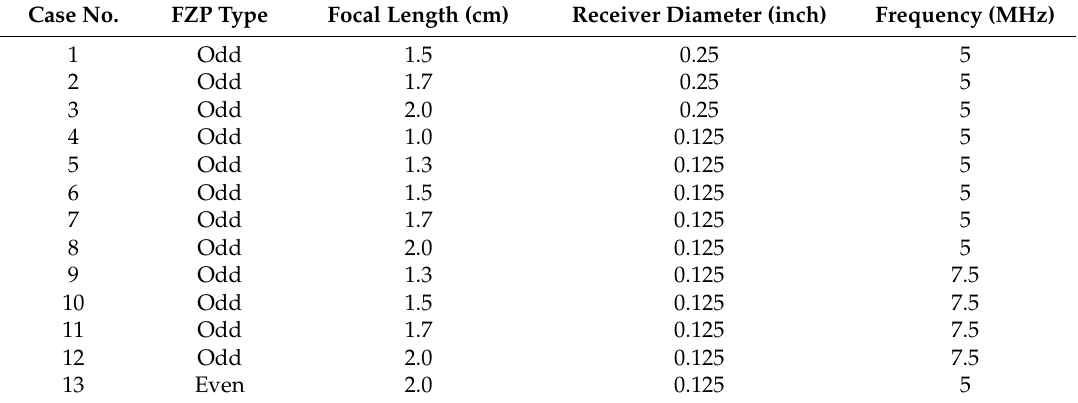
Table 2. Various combinations of focal length, receiver size and frequency for optimal design of FZP